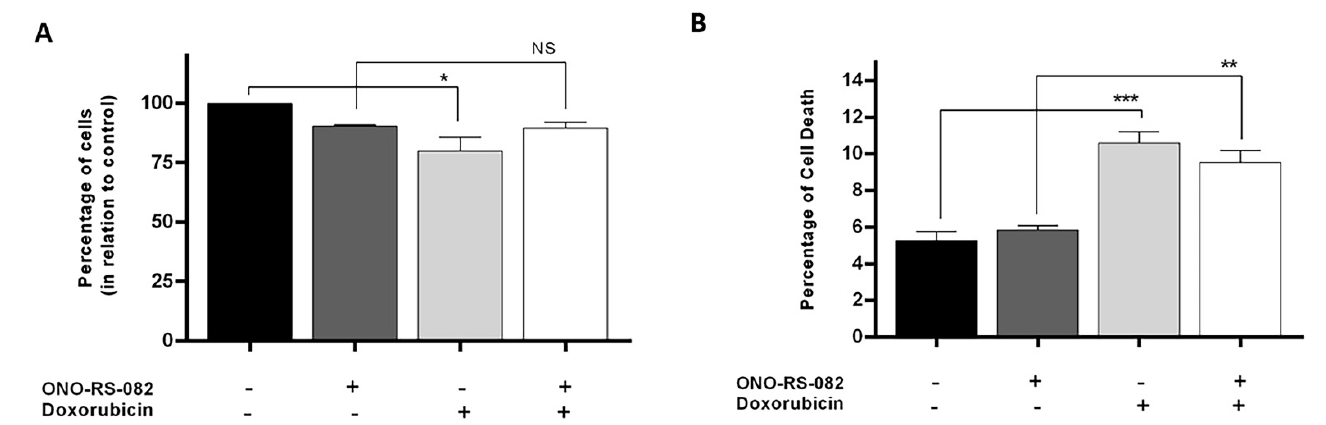
Figure 6. Analysis of the effect of a recycling pathway inhibitor (ONO-RS-082) on cell growth and cell death of NCI-H460 cells to doxorubicin, by SRB ( A ) and Annexin-V-FITC flow cytometry ( B ), respectively. Cells were pretreated for 16 h with ONO-RS-082 (2.5 µM) and further treated for 48 h with doxorubicin (4.7 nM in SRB and 20 nM in Annexin-V-FITC). Results were analysed in relation to control cells and are presented as the mean ± SEM from three independent experiments. * p ≤ 0.05, ** p ≤ 0.005, *** p ≤ 0.0005, NS—non-significant.